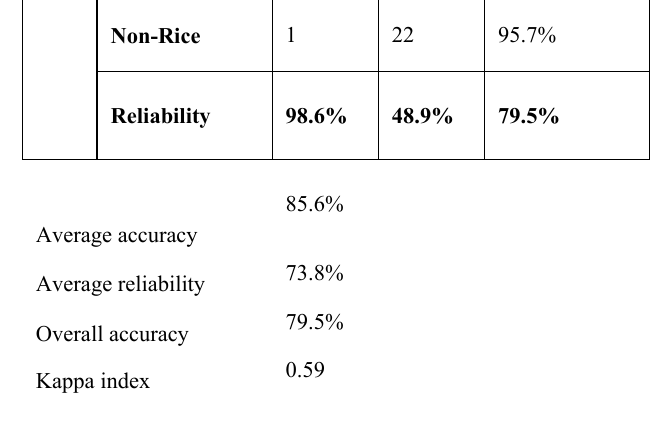
Table.6 Confusion matrix for accuracy assessment of rice